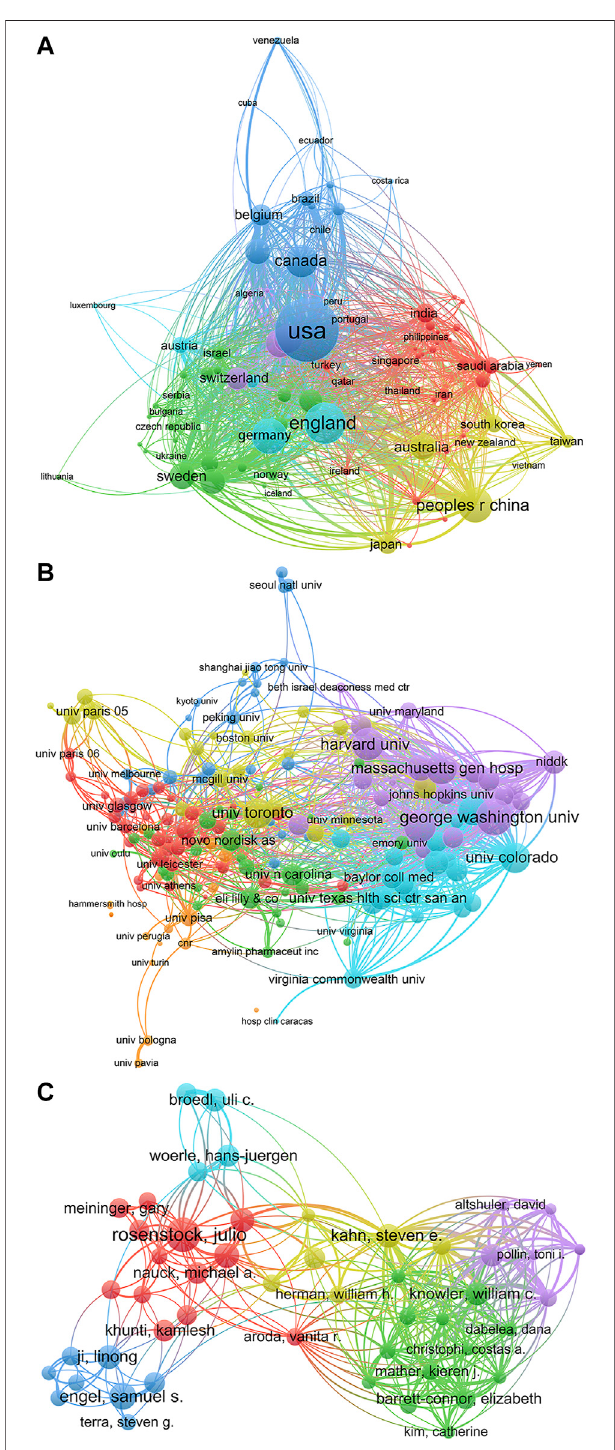
FIGURE 3 | Academic collaboration between different countries/ regions, institutions, and authors in metformin research area. (A) Academic collaboration between different countries/regions. (B) Collaboration between different institutions. (C) Collaboration between different authors.